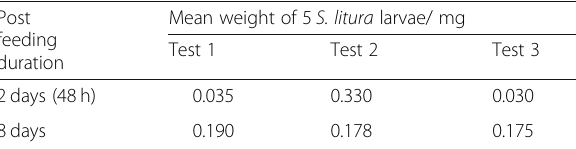
Table 5 Cyanogenic capacity (HCNc) of crushed leaf tissue monitored over an hourly basis with Feigl-Anger